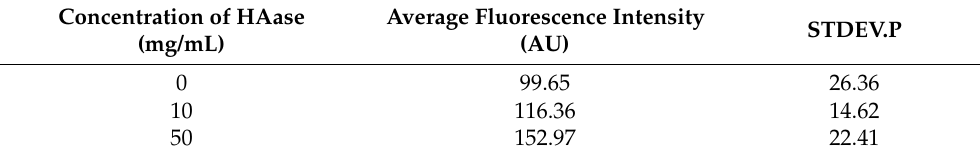
Table 4. The fluorescence intensity of the CUR-MNs containing different HAase concentrations.